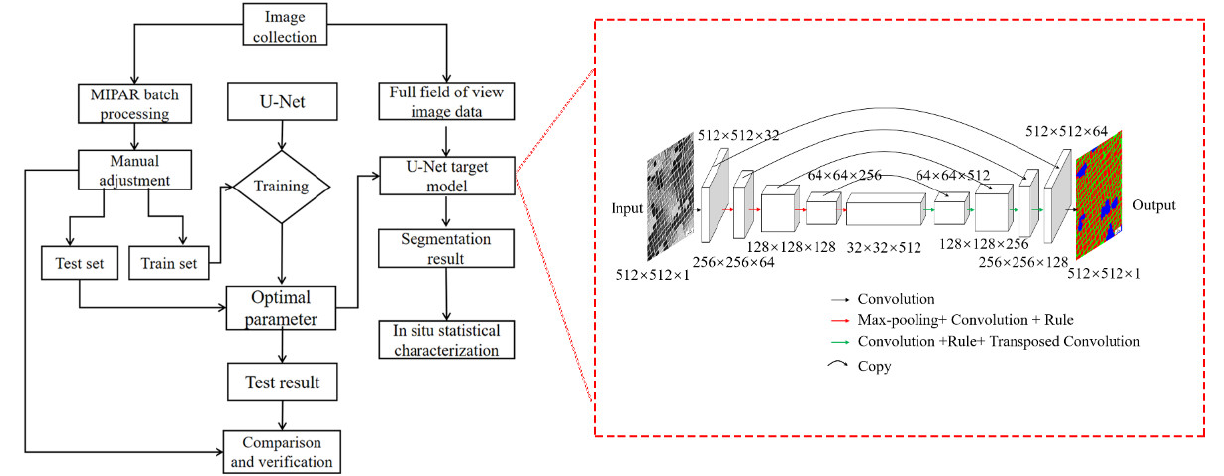
Figure 1. Quantitative characterization process of second phases and architecture of neural network employed in our method.